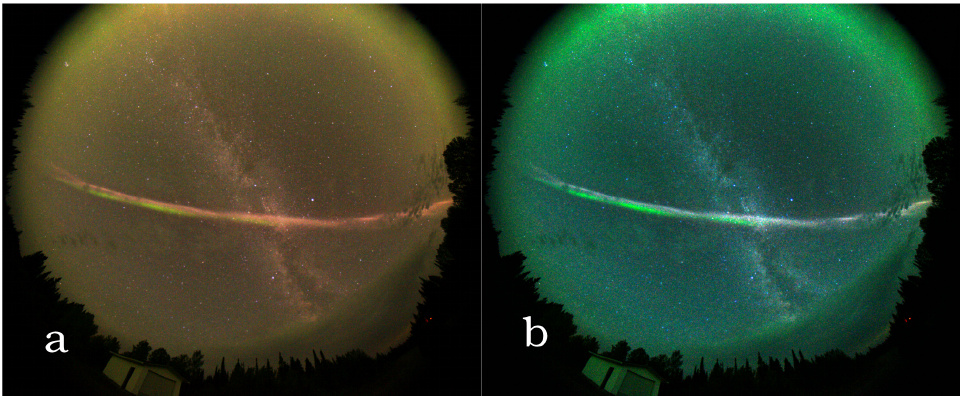
Figure 10. Different representations of the same photo taken of Strong Thermal Emission Velocity Enhancement (STEVE) at a light pollution free location. ( a ) real colours ( b ) 3800 K white balance with additional